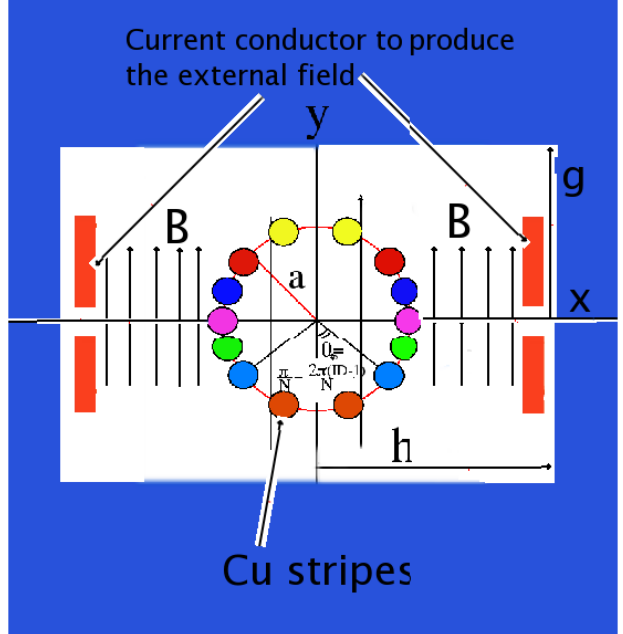
FIG. 3. (Color) The schematic picture of the rf-shielded cham- ber, which is surrounded by the ferromagnetic yoke that is denoted by the blue object. The current conductors excite the external magnetic field B ð t Þ . Cu stripes are symmetric to the x ¼ þ 0 plane. Each of the stripes is defined by ð(cid:2) a sin ð (cid:1) N 2 (cid:1) ð ID (cid:1) 1 Þ Þ ; (cid:1) a cos ð (cid:1) þ 2 (cid:1) ð ID (cid:1) 1 Þ Þ ; z Þ , with ID used as the index to N N N specify the IDth stripe that runs from 1 to N= 2 , N is the total number of stripes, a is the radius of chamber, 2 g is the gap height of yoke, and 2 h is the gap width of yoke. The direction of the external magnetic field is vertical y .